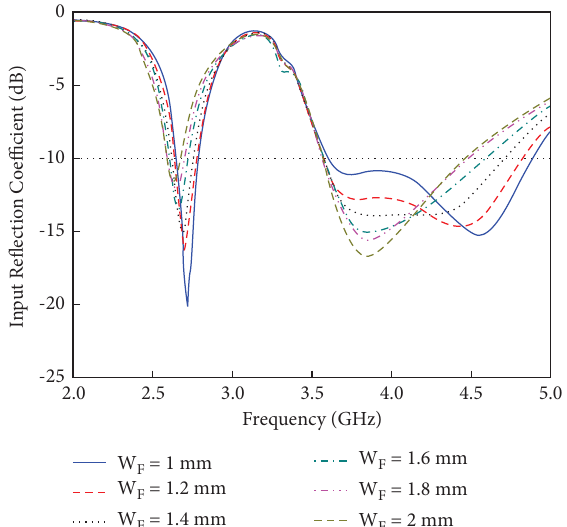
Figure 3: Simulated refection coefcient of the proposed dual- band MTM antenna by varying W F 3 .